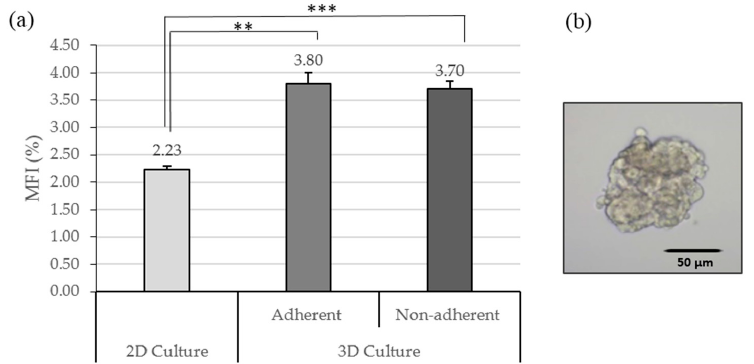
Figure 6. CSCs population analysis. ( a ) Mammospheres Forming Index (MFI; %) of 2D culture and all 3D conditions. Results are shown as mean ± standard error. ( b ) Inverted optical microscopy images of a MCF7 mammosphere. ** ( p < 0.01) and *** ( p < 0.001) indicate levels of statistically significance.